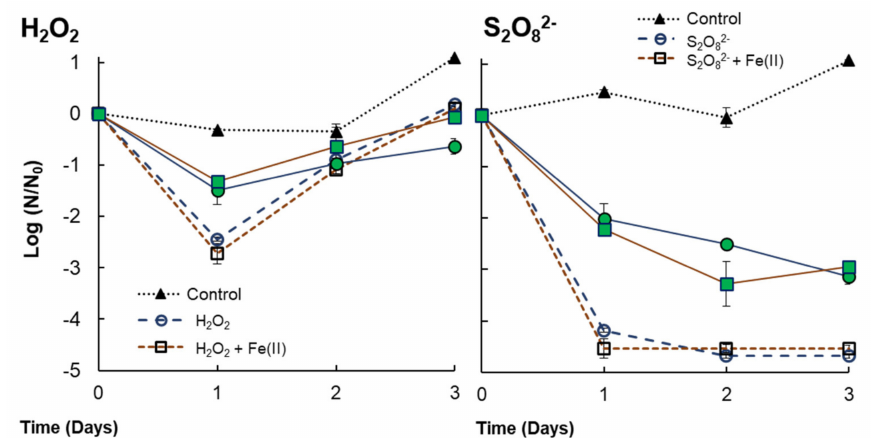
Figure 6. Inactivation of V. alginolyticus for single H 2 O 2 or S 2 O 82 − (+ Fe(II)) treatments [H 2 O 2 ] = 0.29 mmol/L; [S 2 O 82 − ] = 3 mmol/L; [Fe(II)]= 18 µ mol/L. Filled markers indicate co-cultures with Anabaena sp., while empty markers indicate single cultures of V. alginolyticus